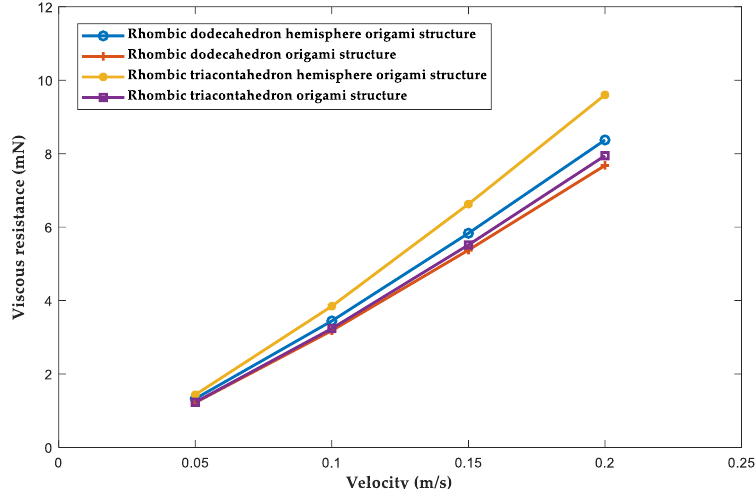
Figure 4. The relationship curve between viscous resistance and swimming speed of different origami structures.